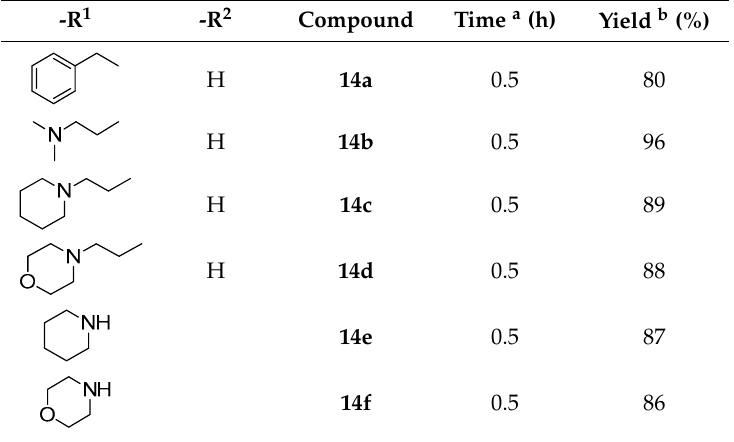
Table 6. Chemical structures and yields obtained for the synthesis of 1 7a – f